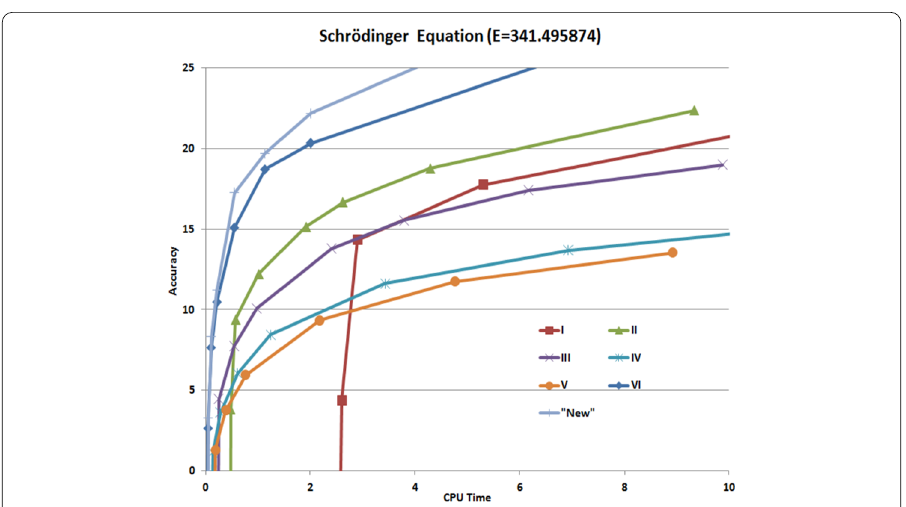
Figure 3 Digits of accuracy versus CPU times (in seconds) for different methods, corresponding to the eigenvalue